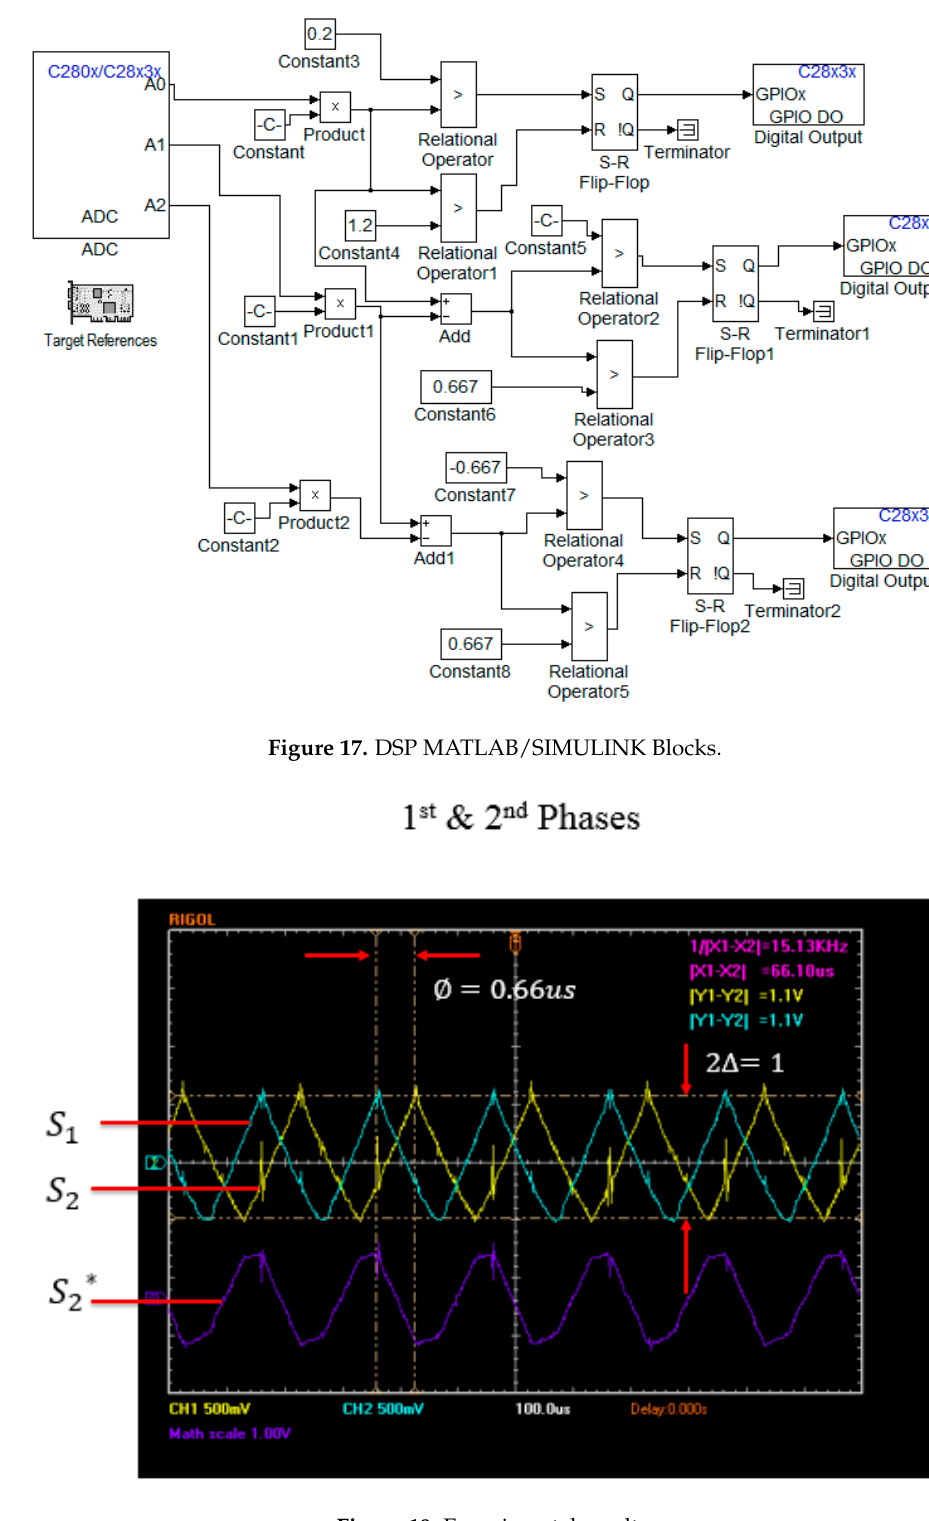
Figure 18. Experimental results.